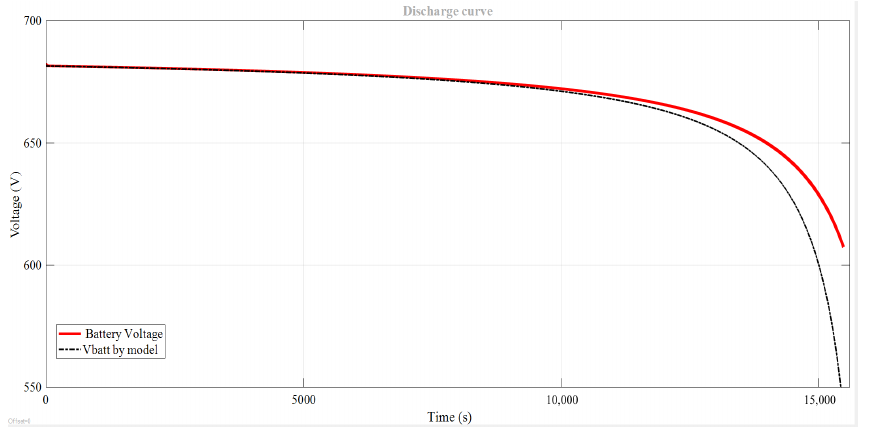
Figure 7. Battery discharge curves: red line, SimPowerSystems battery, and implemented nonlinear Treblay model in gray.